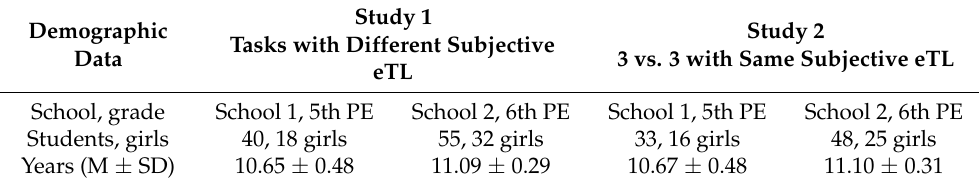
Table 2. Characteristics of the students participating (by